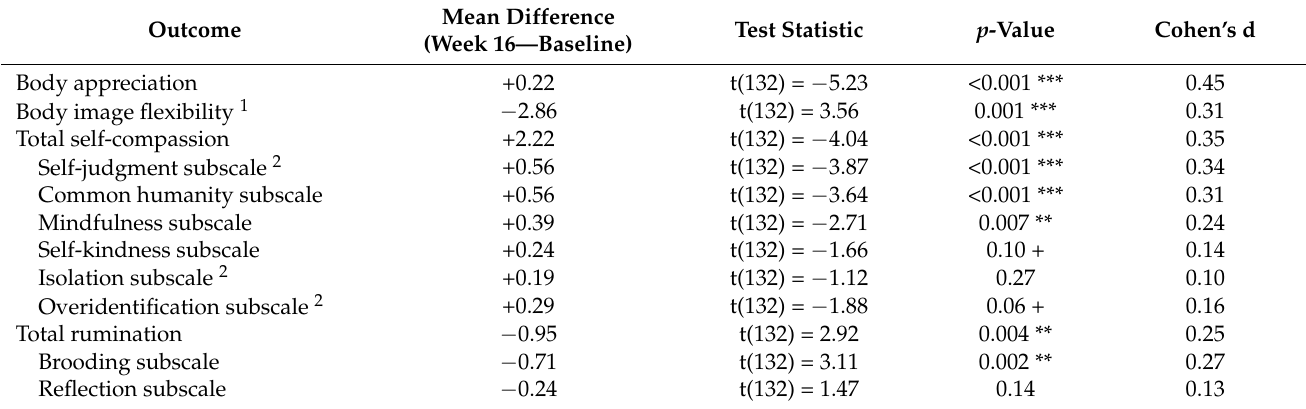
Table 1. Change in primary outcomes from baseline to week